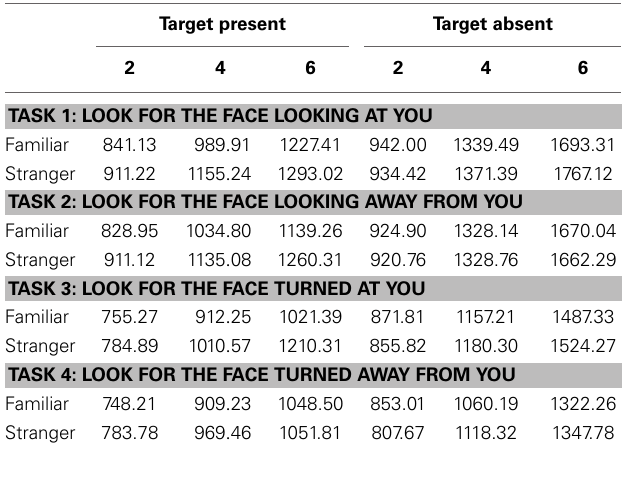
Table 1 | Mean RTs [ms] for each condition and each task, correct responses only.